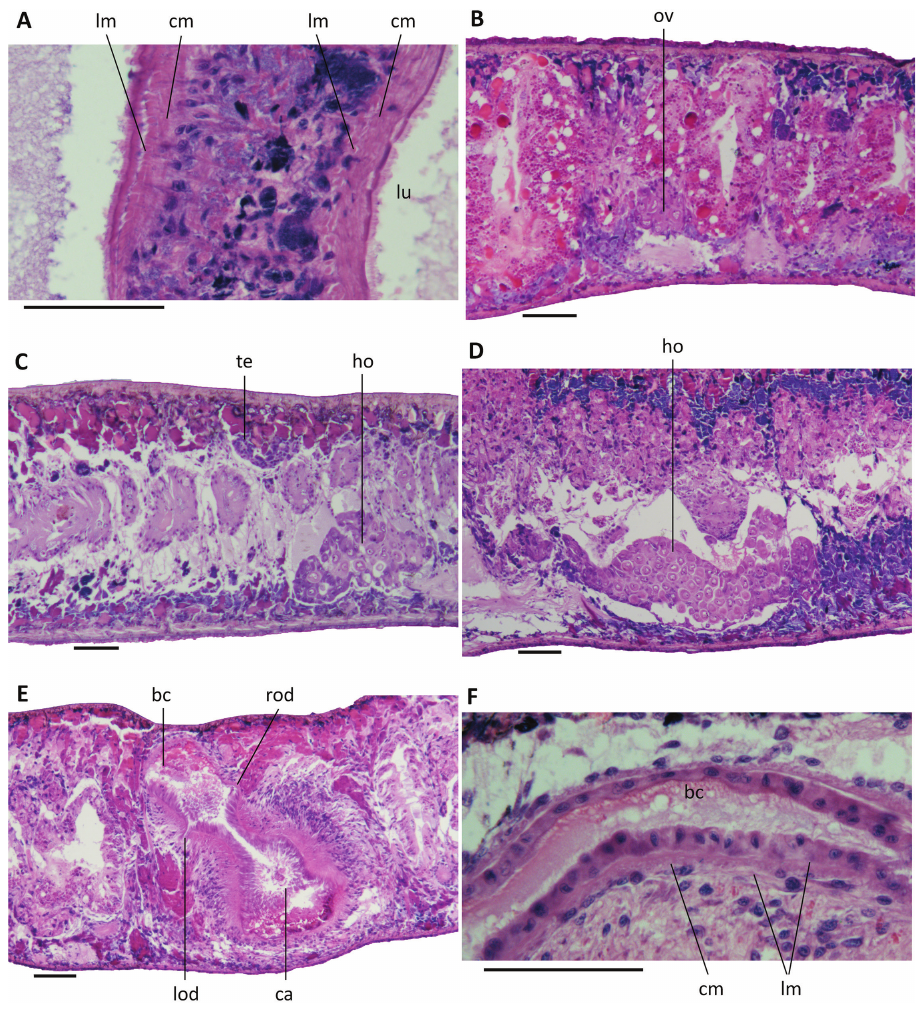
Figure 5. Dugesia circumcisa A transverse section of pharynx of paratype YWSZ11, showing musculature B sagittal section of paratype YWSZ8, showing poorly developed ovary C sagittal section of paratype YWSZ9, showing hyperplasic ovaries and poorly developed testes D sagittal section of paratype RMNH VER. 19974.a, showing hyperplasic ovaries E transverse section of paratype YWSZ11, showing openings of oviducts into bursal canal F sagittal section of holotype YWSZ2, showing musculature of bursal